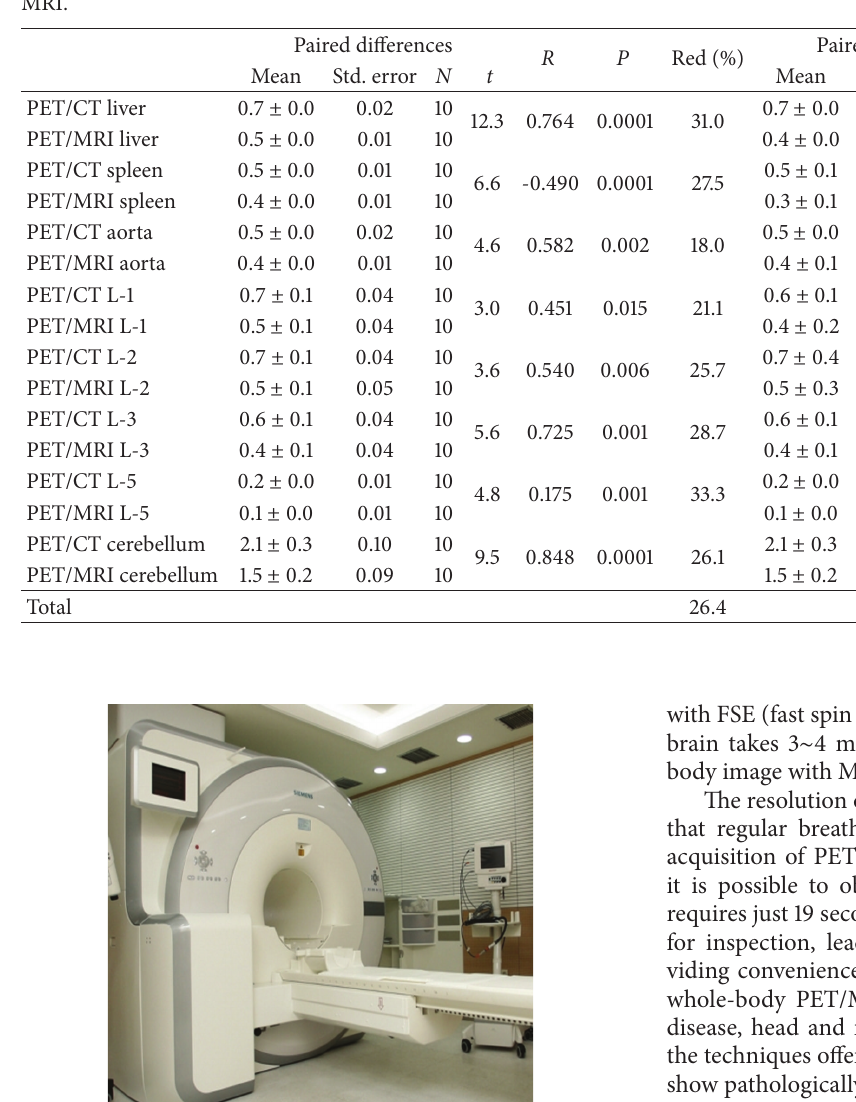
-maximum normal volumes corresponding to PET/CT and PET/ BSA